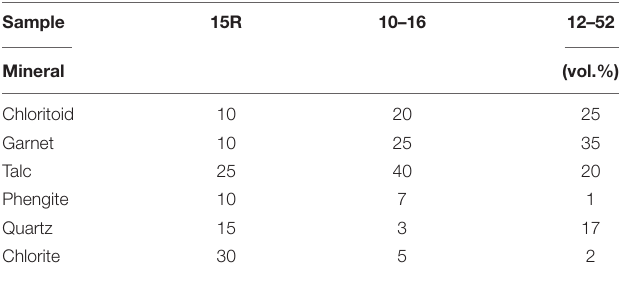
of chloritoid and layered minerals along the foliation plane.